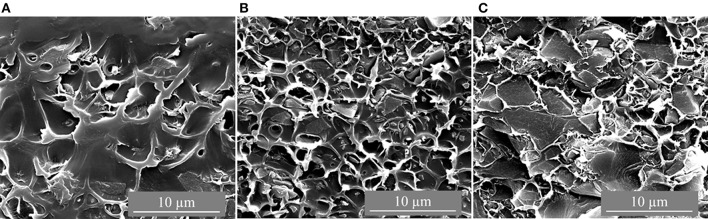
Cross-section SEM images of 8 wt% (A), 16 wt% (B) and 24 wt% (C) of CTF-1@PSF MMM.